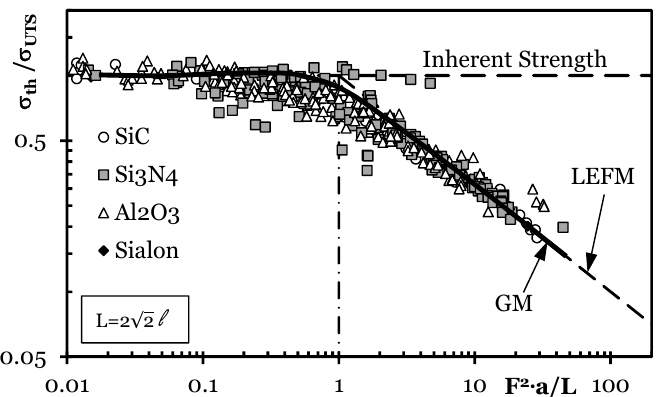
Figure 2: Accuracy of gradient enriched tip stresses in estimating the transition from the short- to the long-crack regime under Mode I static loading, the mechanical properties of the considered engineering ceramics being summarised in Tab